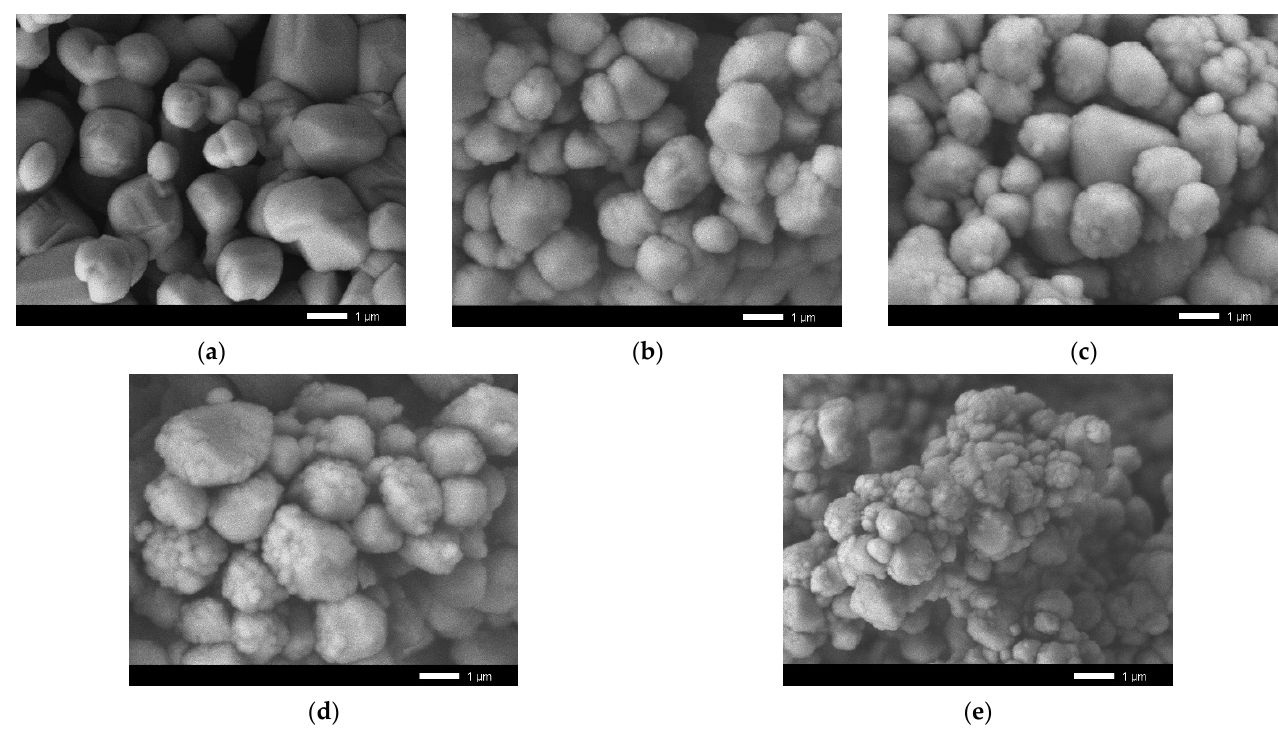
Figure 2. SEM ‐ images of the studied samples: ( a ) pristine; ( b ) 0.05 mol.%; ( c ) 0.10 mol.%; ( d ) 0.15 mol.%; ( e ) 0.20 mol.%.